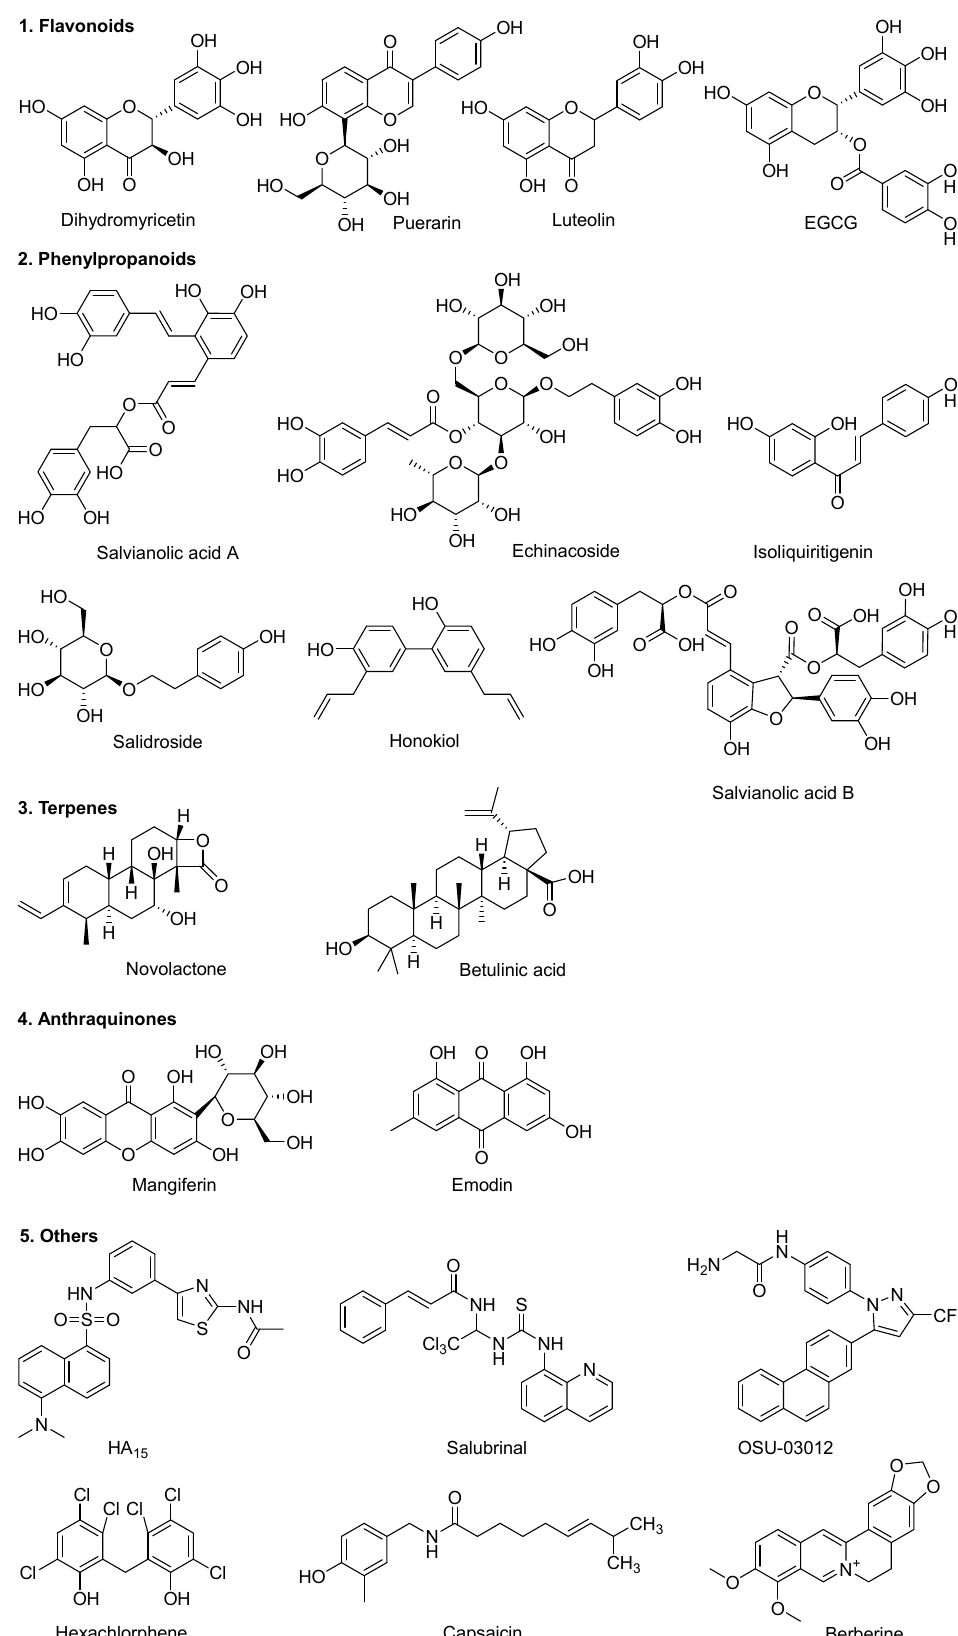
Figure 3. GRP78 inhibitors targeting its ATPase/nucleotide-binding domain.